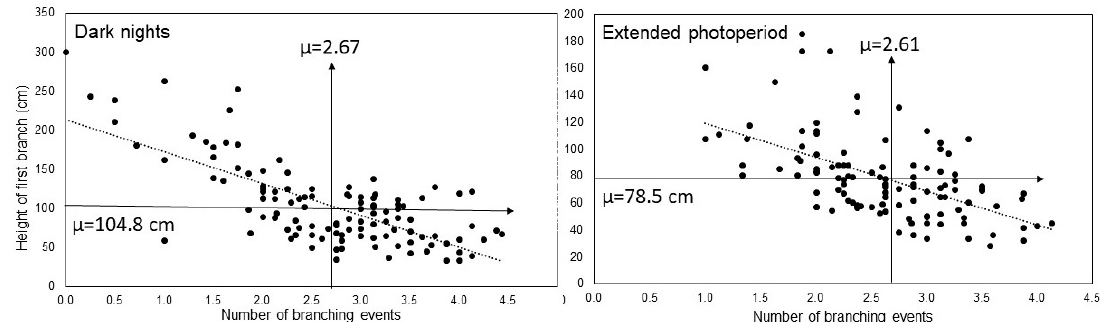
Figure 7. Relationship between number of branching events and height of the first branching in 116 genotypes grown under DN ( left ) and EP ( right ). The average values ( μ ) are shown for each treatment.